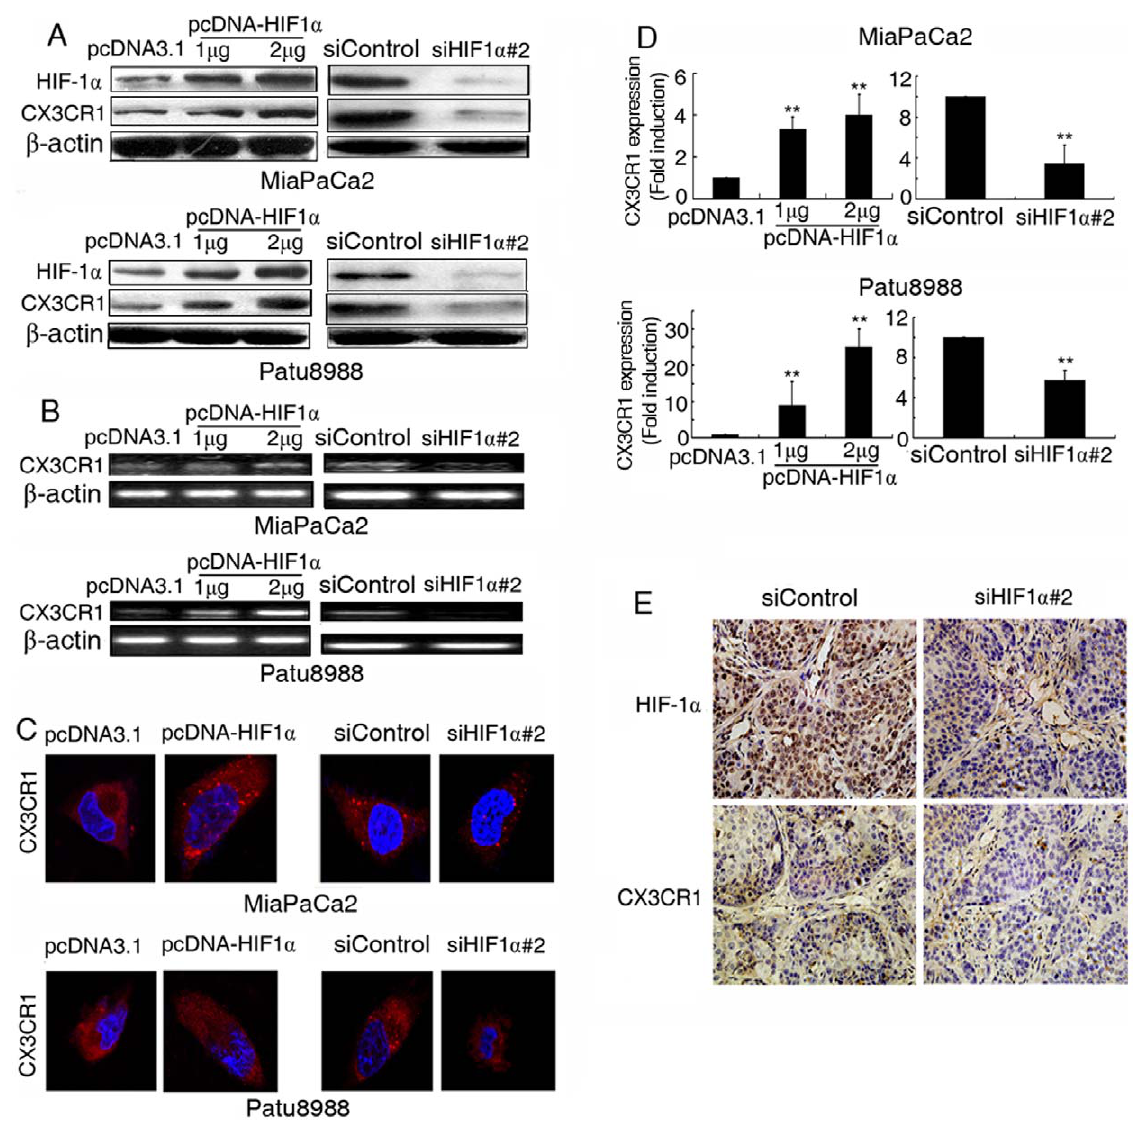
Figure 2. HIF-1 a directly regulated the expression of CX3CR1. ( A ) MiaPaCa2 (upper) and Patu8988 (lower) cells were transfected with pcDNA3.1-HIF1 a plasmids (1 m g, 2 m g) (left) or siHIF1 a # 2 (50 nM) (right) for 48 h and assessed by Western-blotting. ( B ) MiaPaCa2 (upper) and Patu8988 (lower) cells were transfected with pcDNA3.1-HIF1 a plasmids (1 m g, 2 m g) (left) or siHIF1 a # 2 (50 nM) (right) for 48 h and assessed by semiquantitative PCR. ( C ) MiaPaCa2 (upper) and Patu8988 (lower) cells were transfected with pcDNA3.1-HIF1 a plasmids (1 m g) (left) or siHIF1 a # 2 (50 nM) (right) for 48 h and assessed by confocal microscopy. Representative images for the analysis show CX3CR1 expression (in red) and nuclei (in blue) in pancreatic cancer cells. ( D ) MiaPaCa2 (upper) and Patu8988 (lower) cells were transfected with pcDNA3.1-HIF1 a plasmids (1 m g, 2 m g) (left) or siHIF1 a # 2 (50 nM) (right) for 48 h and assessed in EPICS XL flow cytometry. Fluorescence was determined to measure the expression of CX3CR1. Value in control cells (pcDNA3.1 or siControl) were used as the baseline. Value in (pcDNA-HIF1 a or siHIF1 a # 2) were shown as the fold induction in relation to the baseline.** P , 0.01 versus control. ( E ) Immunohistochemistry of tumors originated from MiaPaCa2 cells that were transplanted in nude mice to test the effects of delivery of cholesterol-conjugated siControl (left) or siHIF1 a # 2 (right). (magnification: 6